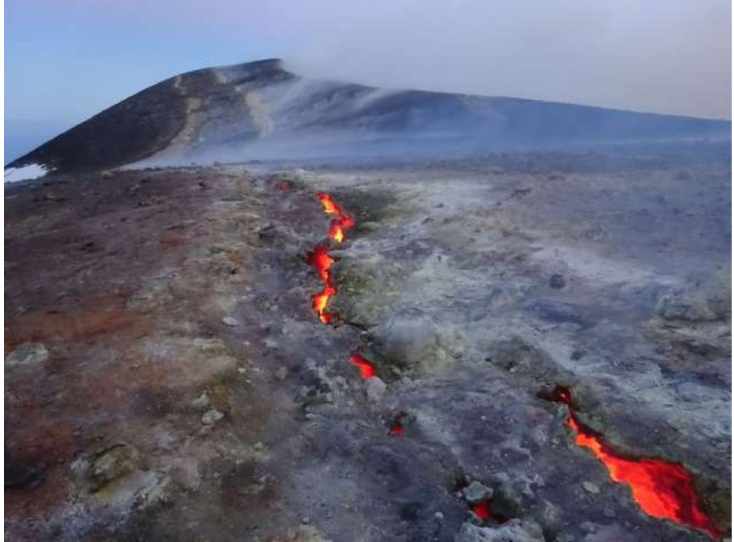
Figure 8. Incandescence of gas fluxed fractures (tens centimeters to meters wide) at Mount Etna summit craters (December